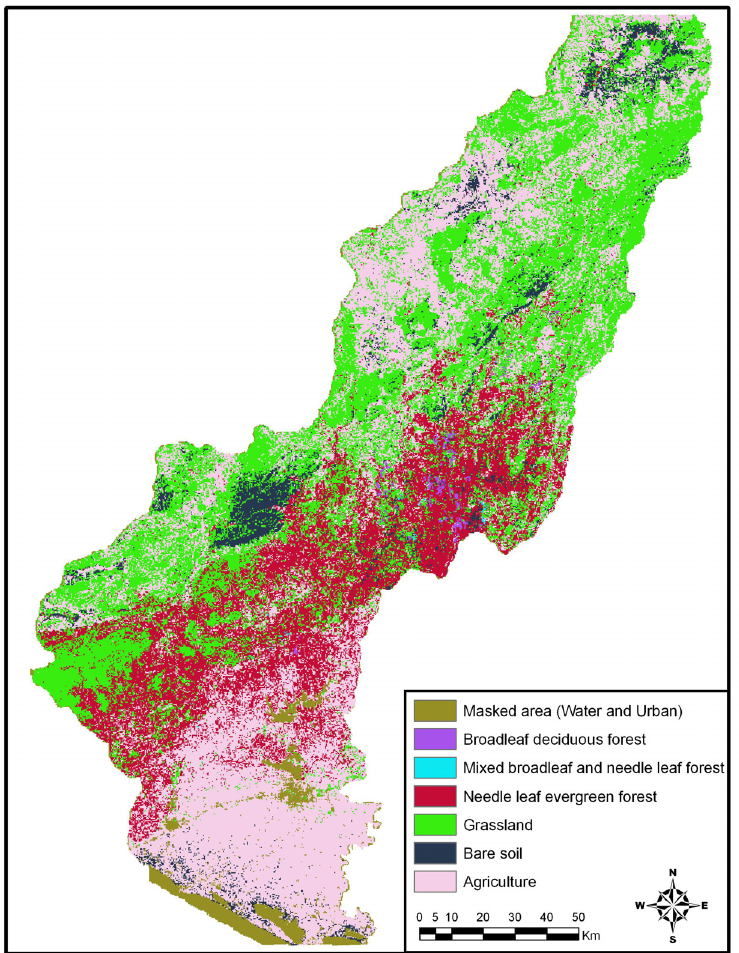
Figure 6. Land cover map derived from Landsat ETM